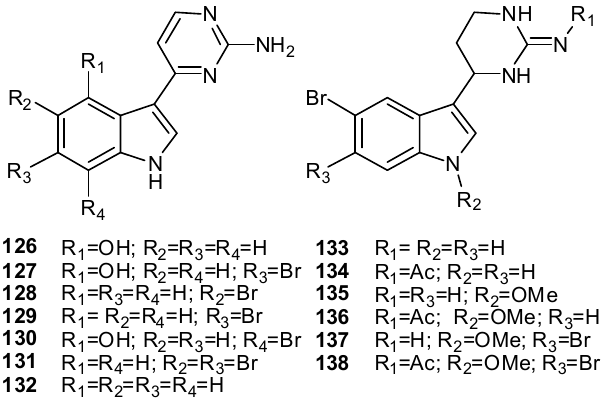
Figure 15. 3-(2-Aminopyrimidine)-indoles (meridianins A–G, 126–132 ) and their reduced forms (aplicyanins A-F, 133–138